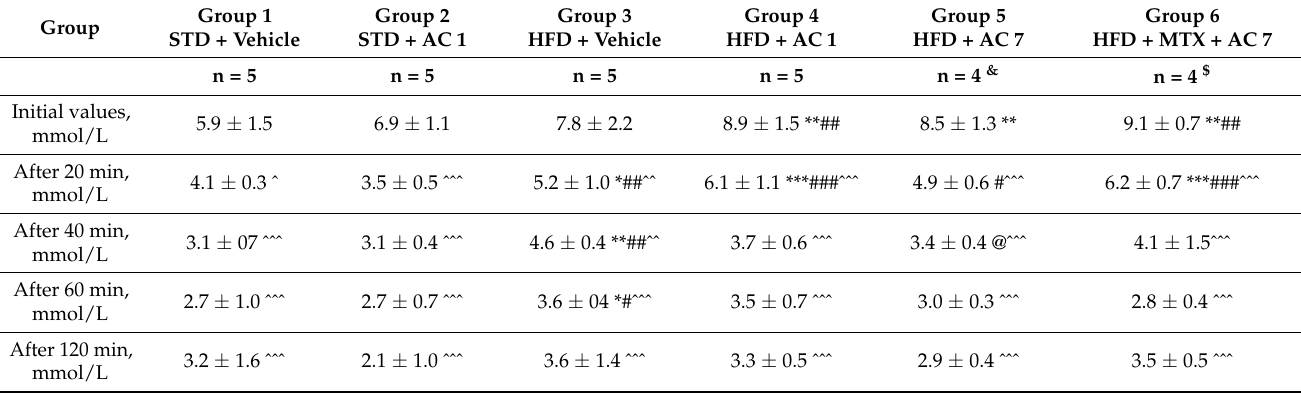
Table 3. Mean values of glucose concentration in the insulin resistance